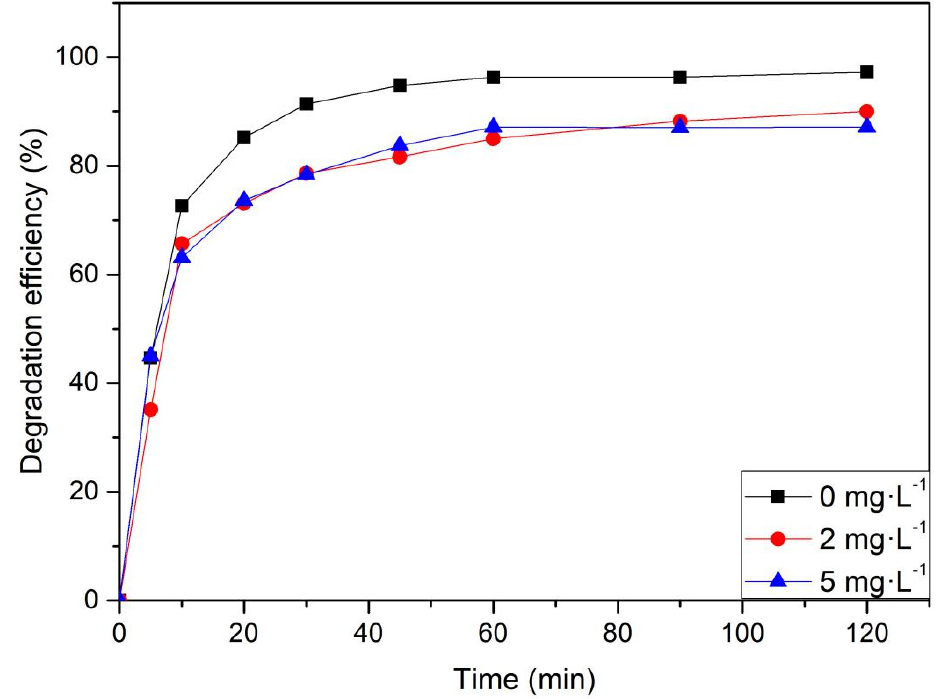
Figure 5. Effect of humic acid (HA) on 2,4-DCP degradation. [2,4-DCP] = 20 mg L − 1 , [Fe(III)-EDDS] = 0.1 mM, [H 2 O 2 ] = 1.0 mM, and pH = 7.0 ± 0.1.